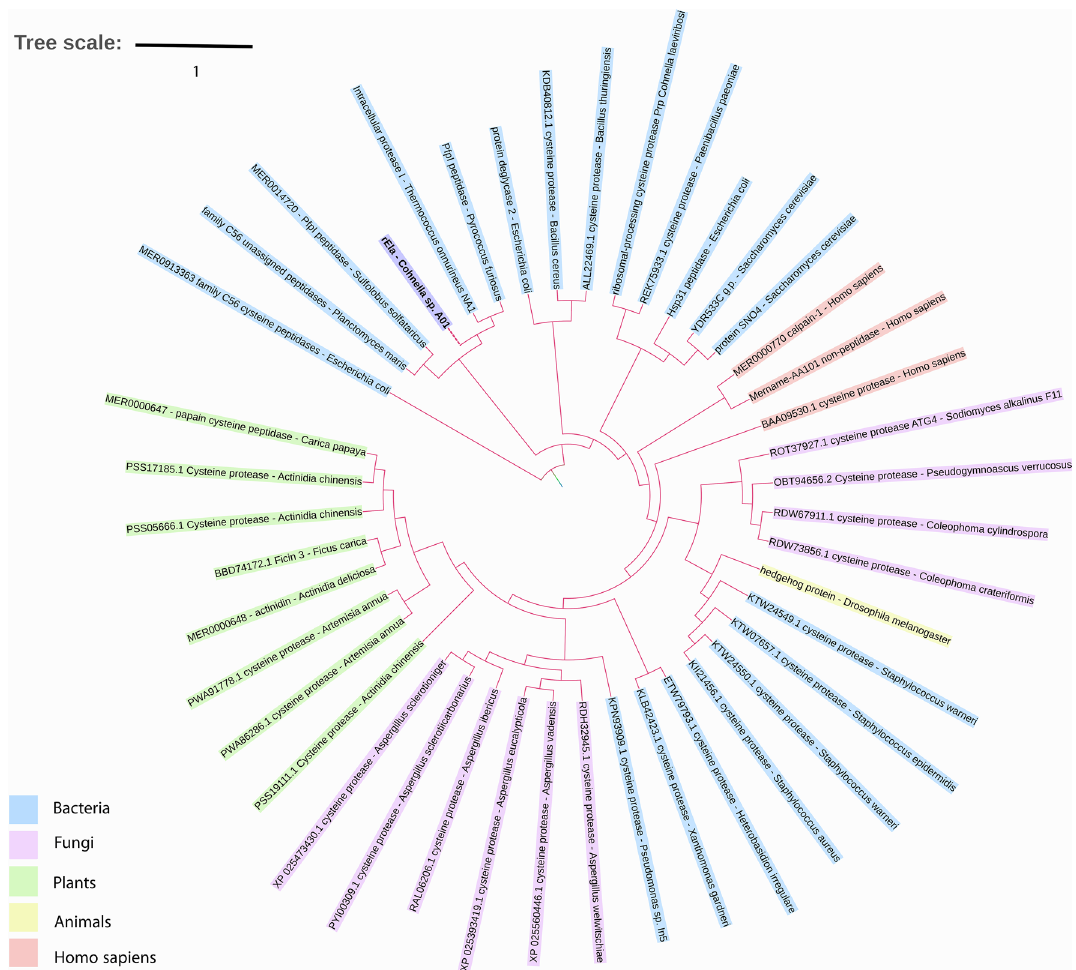
Figure 1. Phylogenetic tree of rEla from Cohnella sp.A01 and cysteine proteases from different species. The tree was constructed using ClustalW in MEGA X program based on the alignment of the cysteine protease sequences with high